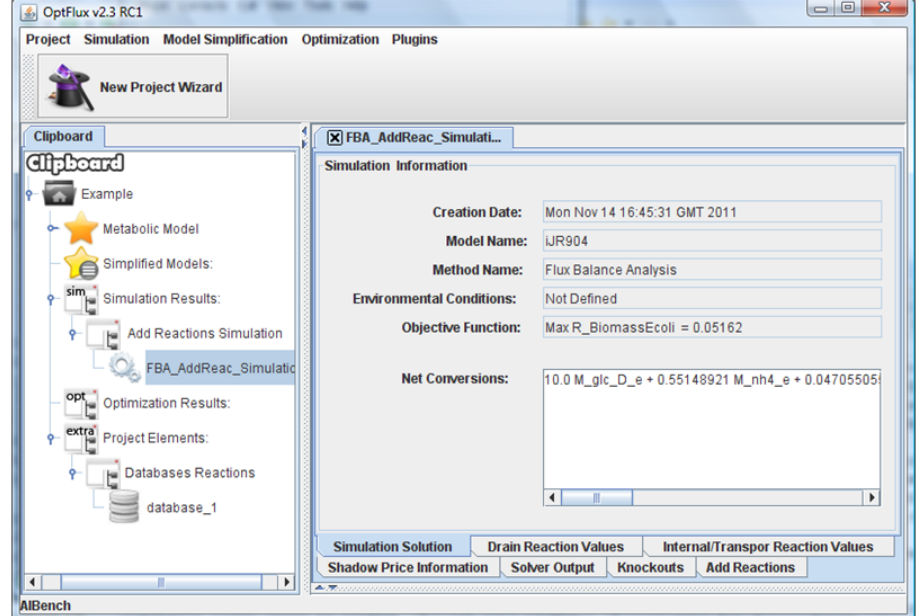
Figure 5: Interface showing simulation results: in the left the clipboard shows the main objects and in the right side the visualization of the main results of mutant simulation are shown in distinct